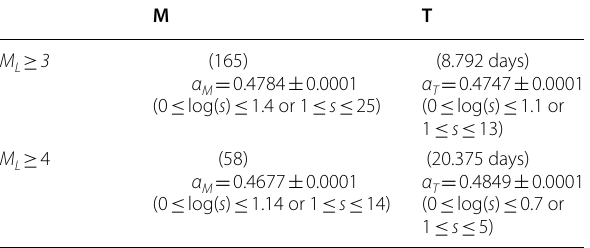
Table 1 The values of α those of α